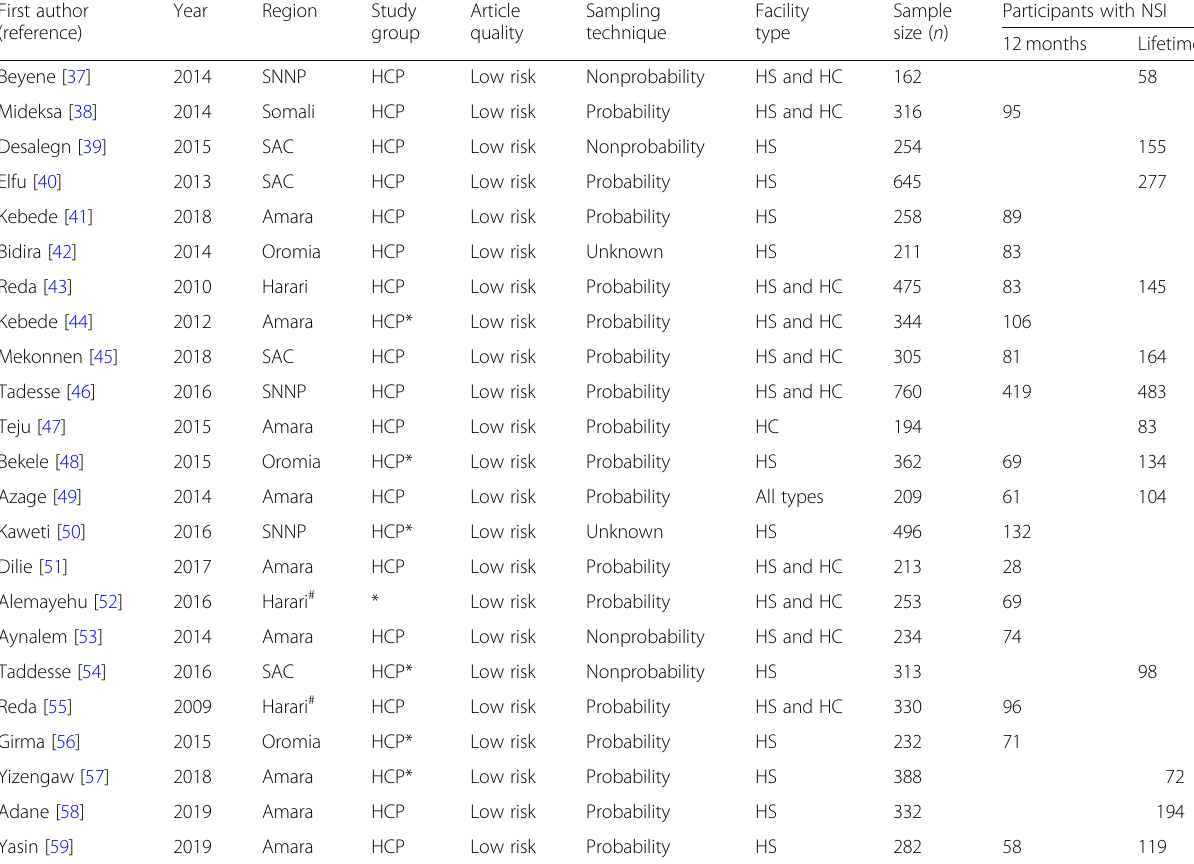
Table 1 Characteristics of the included studies in the meta-analysis of the prevalence of needlestick injury among healthcare workers in Ethiopia,